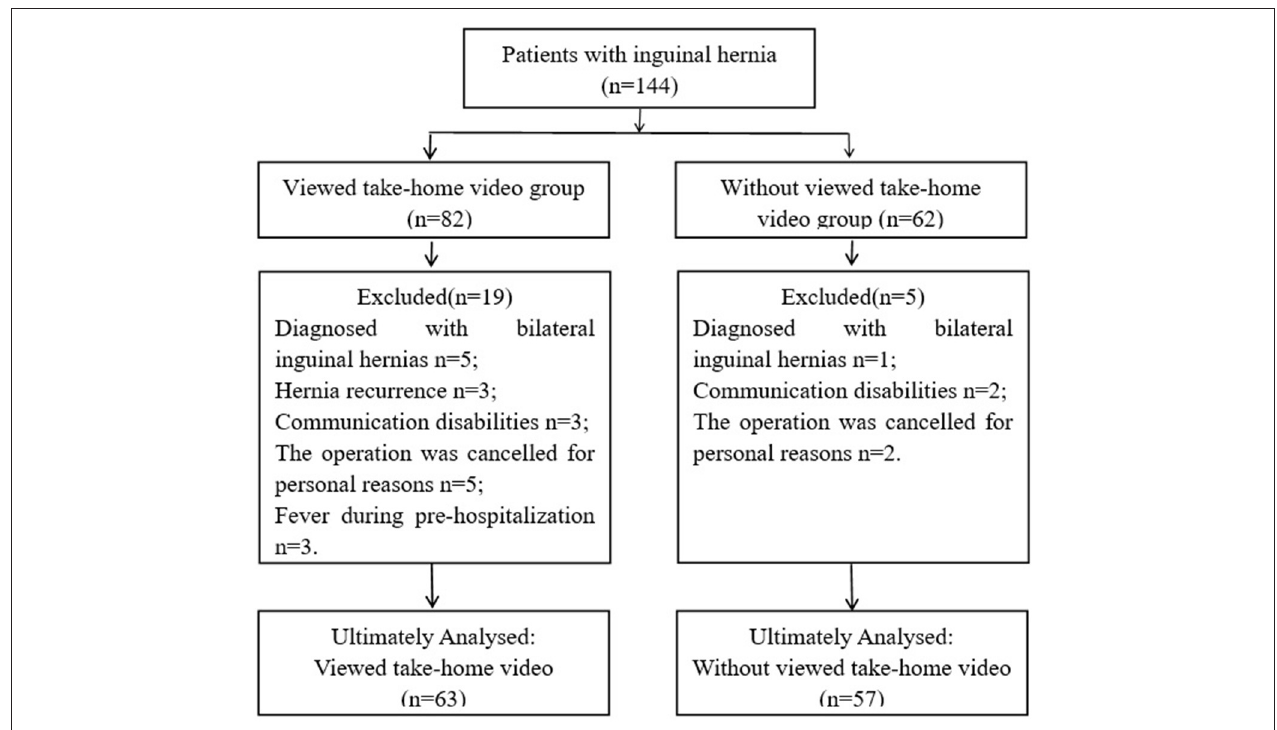
FIGURE 1 | Study flow